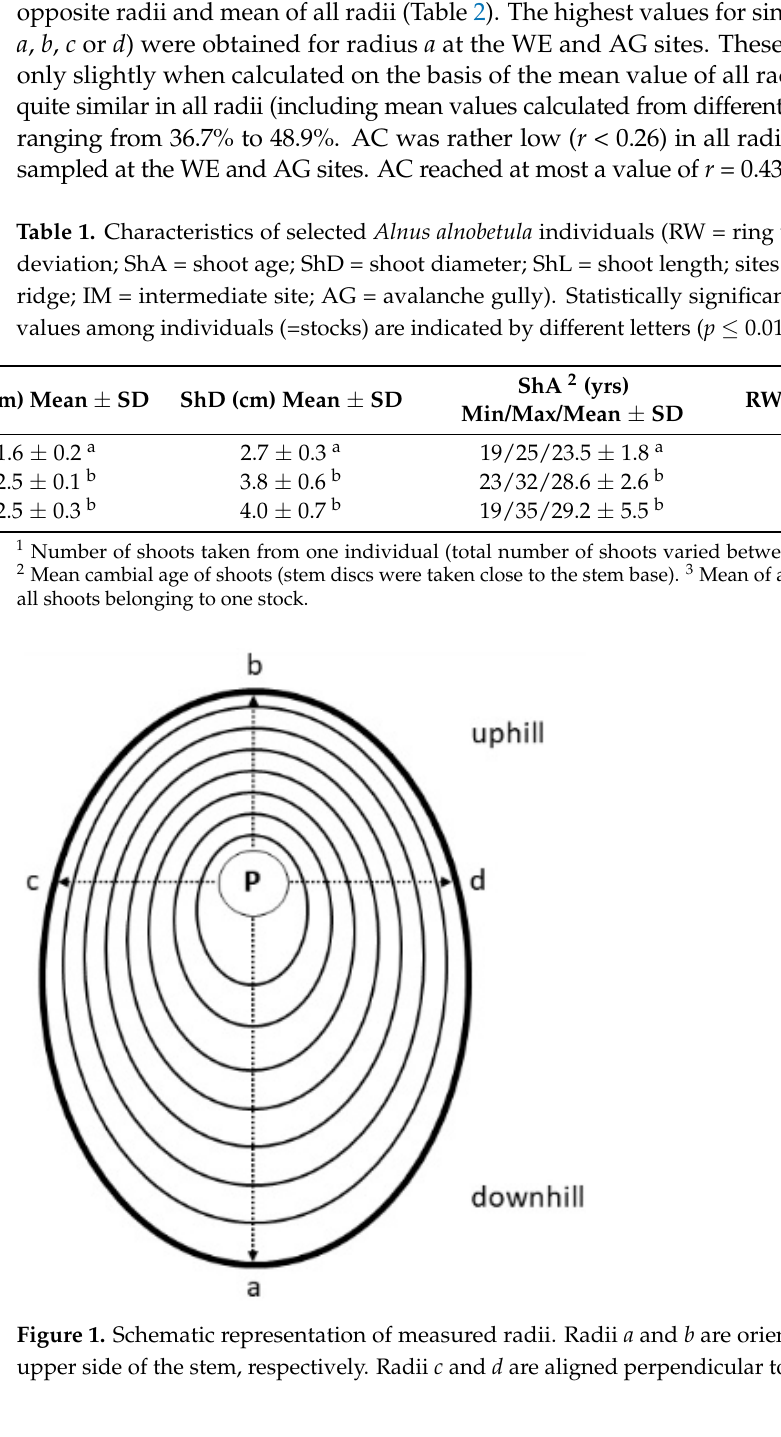
Table 1. Characteristics of selected Alnus alnobetula individuals (RW = ring width; SD = standard deviation; ShA = shoot age; ShD = shoot diameter; ShL = shoot length; sites: WE = wind-exposed ridge; IM = intermediate site; AG = avalanche gully). Statistically signi fi cant di ff erences of mean values among individuals (=stocks) are indicated by di ff erent le tt ers ( p ≤ 0.01; Student’s t -test).